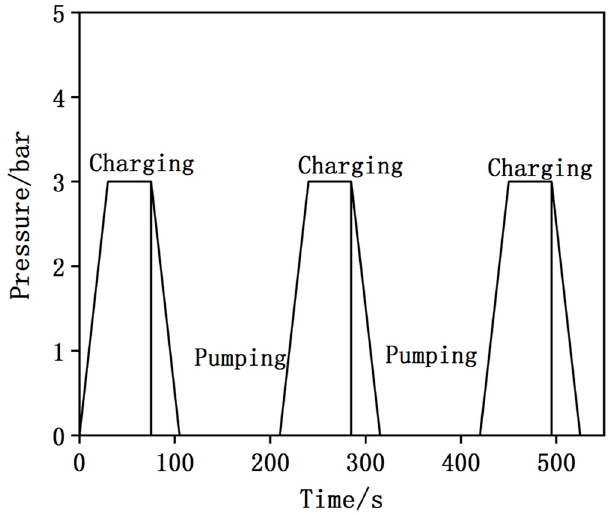
Figure 4. Schematic diagram of vacuum pulse carburizing stage.